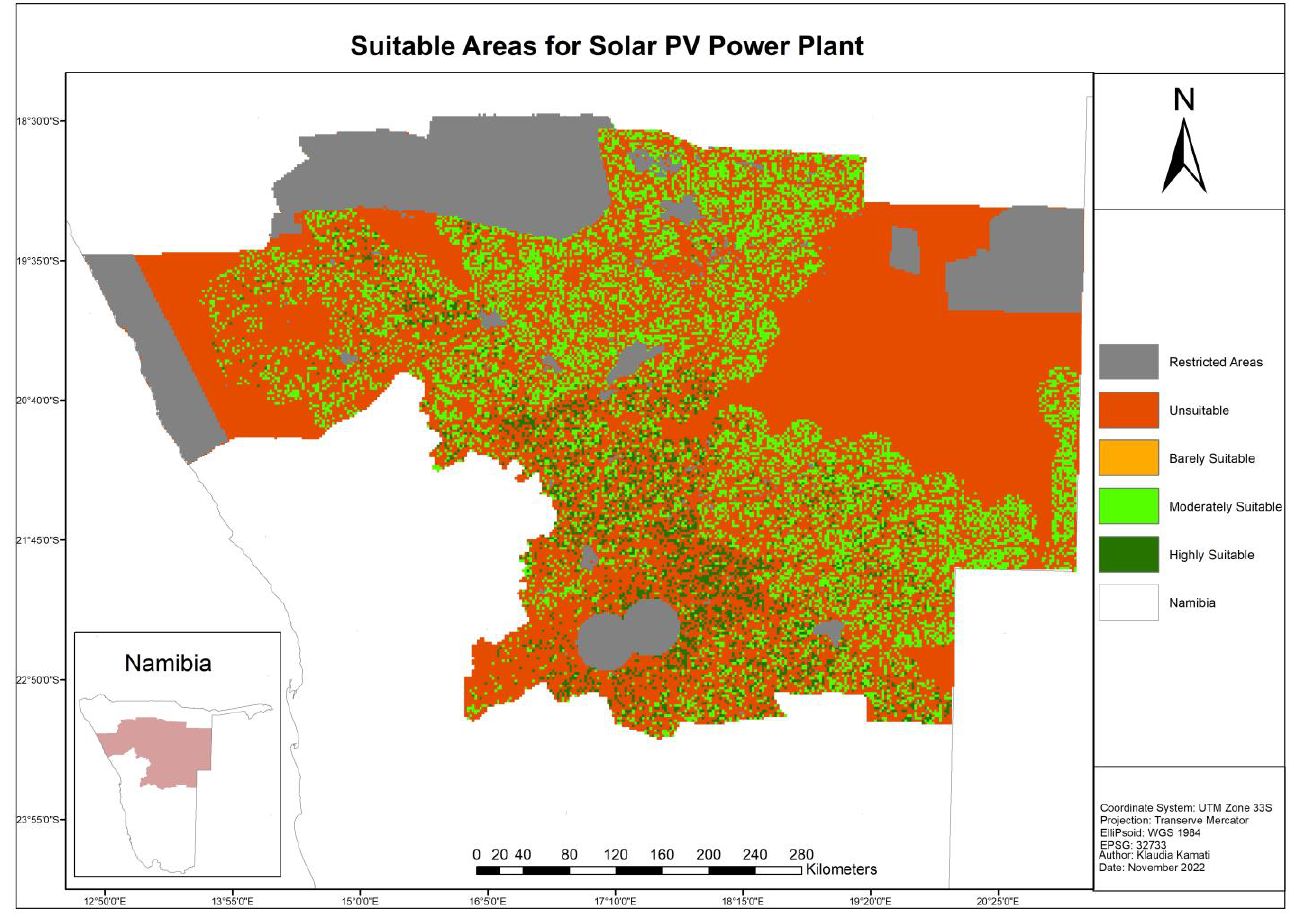
Figure 8. Final solar PV power plant suitability.